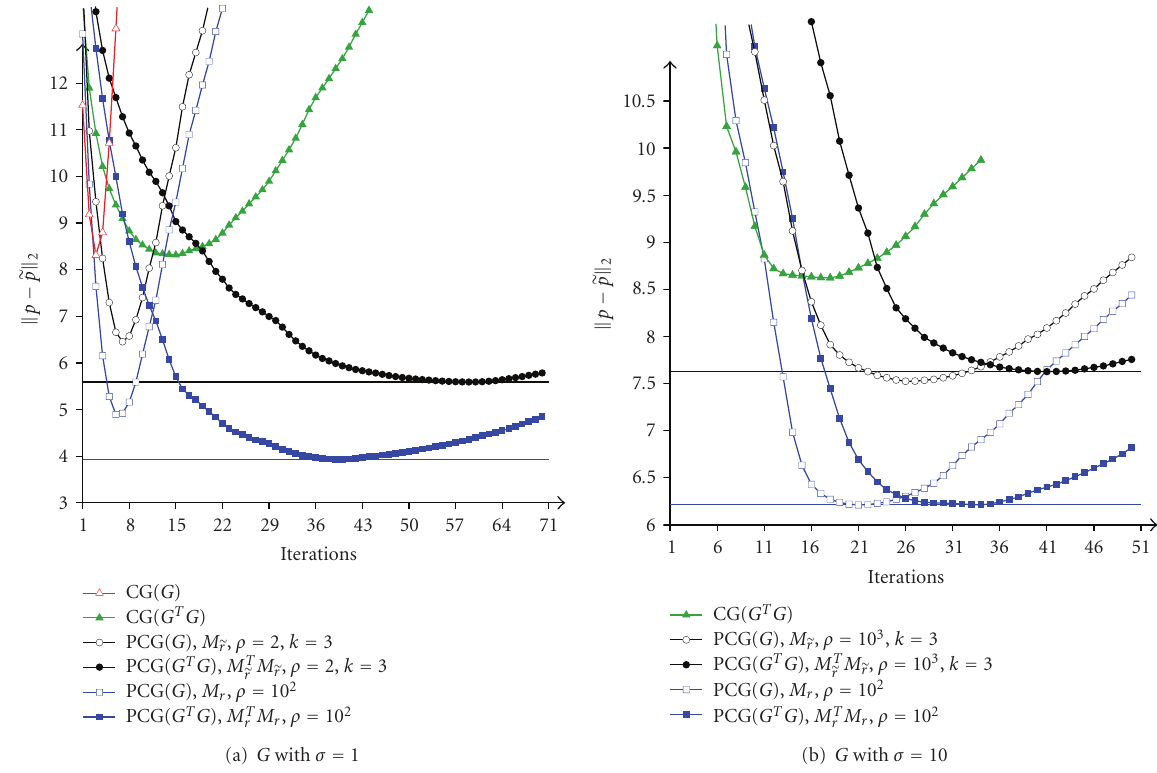
Figure 9: Reconstruction error against iterations for the 1D problem of size n = 10 3 and band = 4 a ff ected by random noise of order (cid:0)(cid:2)(cid:3)(cid:4) 0.1%. G has σ = 1 (a) and σ = 10 (b), respectively. CG is compared to PCG using M r and M (cid:4) r , respectively, for G and G T G